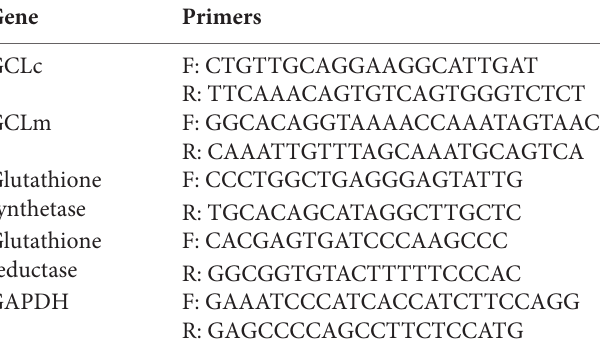
FIGURE 2 | Characterization of NOX isoforms in Primary GECs with ATP stimulation. TaqMan qPCR detection of mRNA expression levels of NADPH oxidase isoforms in human primary GECS with and without ATP (3 mM) treatment for 30 min. N = 3, * p < 0.05 as compared to untreated.